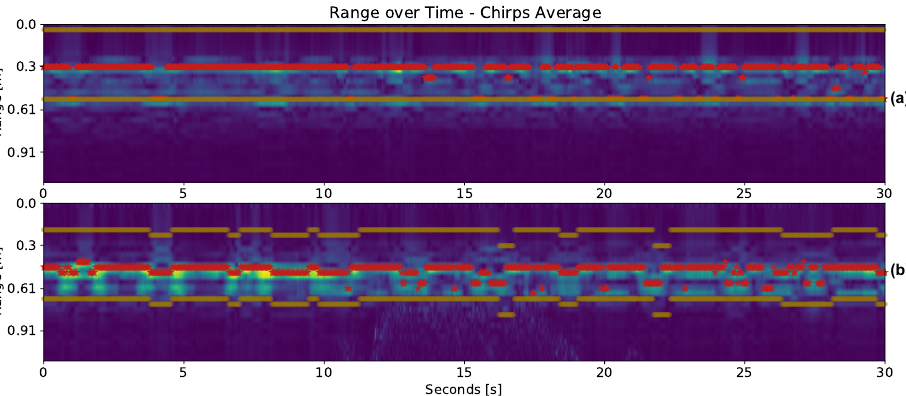
Figure 6. Lines in yellow indicate the defined range bin limits and, in red, the detected maximum bin per frame. Range plotting is generated after clutter removal. In ( a ), the subject did not move much during the session. In ( b ), the range limits vary according to the user’s distance from the radar